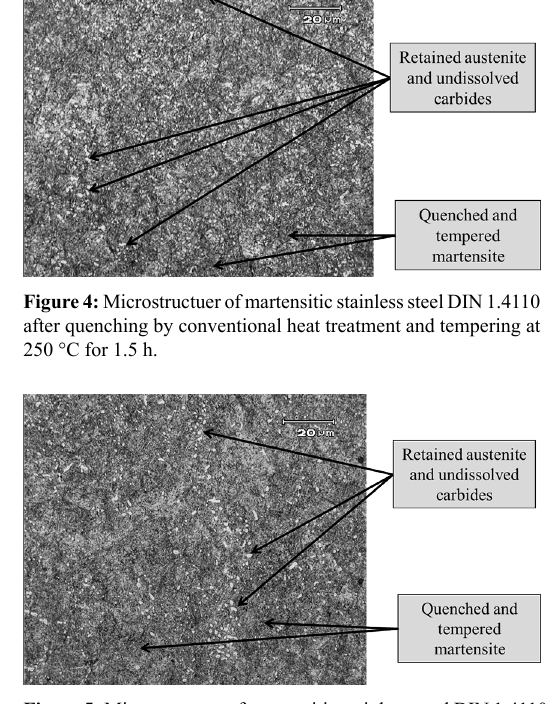
Figure 5: Microstructure of martensitic stainless steel DIN 1.4110 after cryogenic quenching at -80 °C and tempering at 250 °C for 1.5 h.